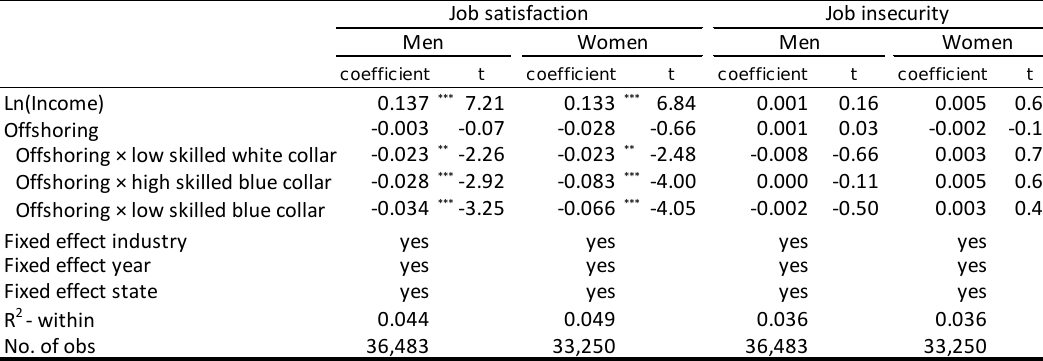
Table 9. Job satisfaction, job insecurity and offshoring, by